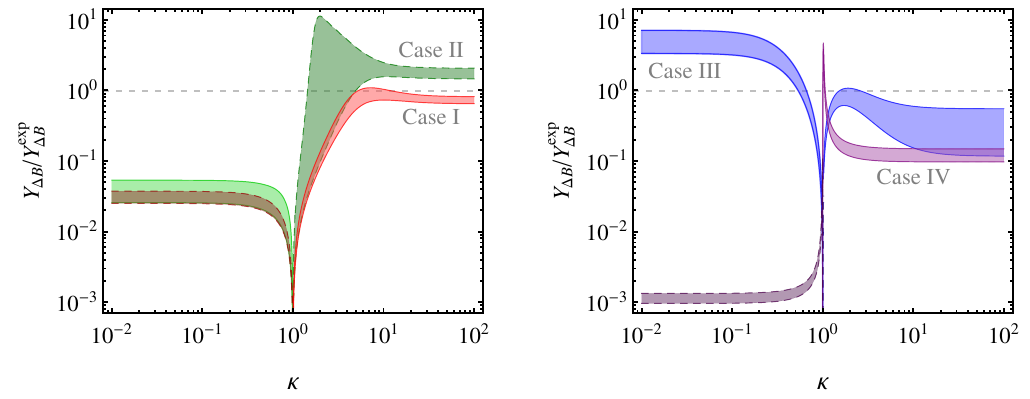
Figure 8 . Expected baryon abundance over the experimental value for the NO solutions (left) and IO solutions (right) for M 0 = 10 12 GeV and (cid:14) = (cid:0) 90 (cid:14) for the Dirac CP phase. The regions with lighter colors and solid borders refer to positive Y (cid:1) B while the regions with darker colors and dashed borders refer to positive (cid:0) Y (cid:1) B . The oscillation observables are varied within 3- (cid:27) of ref. [56].